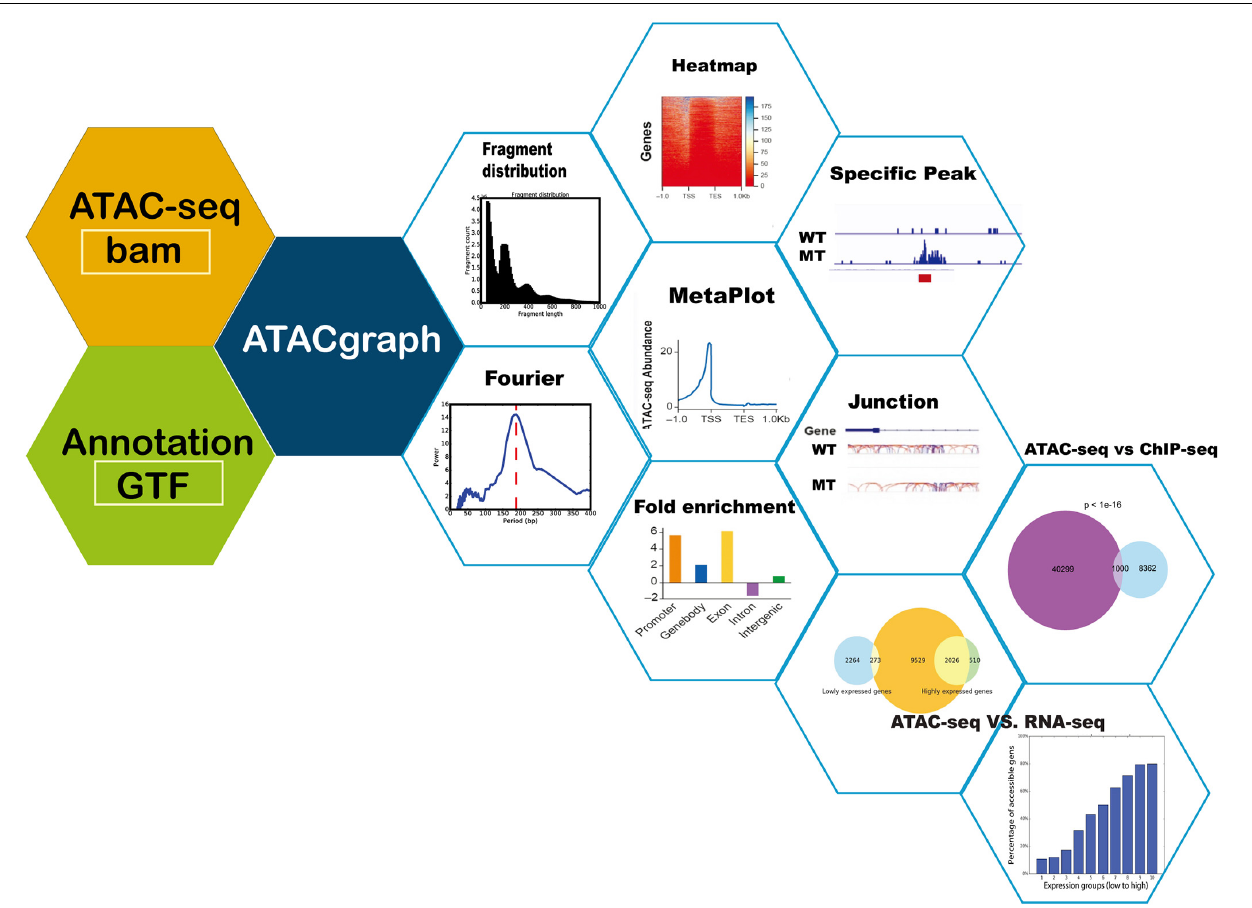
FIGURE 1 | Schematic diagram of ATACgraph. ATACgraph workflow contains 12 modules; most of them are processing independently, and some are sequential processing containing two modules. It can also implement Galaxy-docker to construct pipelines. All modules can handle paired-end and single-end reads; only fragment distribution, FFT (fast Fourier transform), and peak calling need paired-end reads to process. To run all modules of ATACgraph workflow, users provide paired-end aligned BAM file and gene annotation file. The first step is to remove mitochondria or plastid DNA reads and then generate two figures to check quality control (QC) and contain a fragment distribution bar plot and FFT figure to calculate the period of periodicity in the fragment length distribution analysis. Based on fragment distribution figures, the user can set up a cutoff for selecting fragment length for the following analysis. After selecting fragment length, ATACgraph can generate junction tracks, peak calling, visualization for accessible regions, and enrichment analysis for these regions. ATACgraph also include comparisons between two groups of ATAC-seq. Furthermore, ATACgraph also offers a module to compare accessible regions identified using another next-generation sequencing (NGS) method, and output includes a Venn diagram showing the number of overlapping regions and a list of the locations of these regions. ATACgraph generates a bar plot and Venn diagram to show the relationship between accessibility and gene expression level when comparing ATAC-seq and